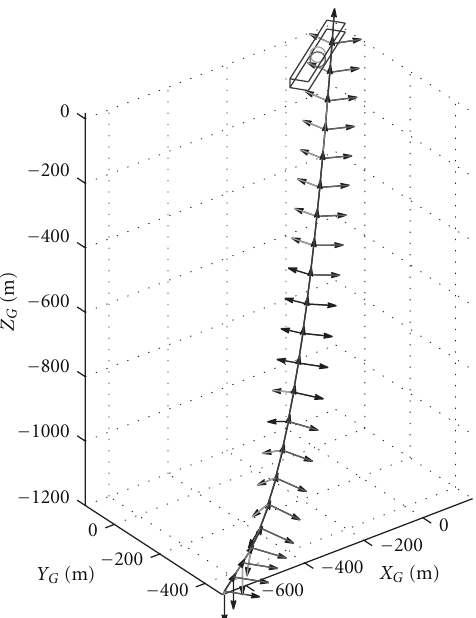
Figure 11: Problem neutral configuration, showing the FPSO, the riser profile and the robot attitude. The orthogonal arrows express the successive local reference frames position and orientation along the riser path. Only 1/8 of the 171 FEM mesh nodes used in the static analysis is shown to facilitate visualization.